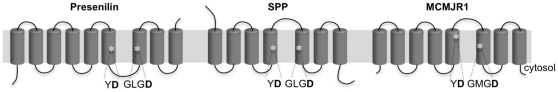
Topologies of presenilin, SPP and MCMJR1.A schematic of the predicted topologies of presenilin [10], SPP [20] and MCMJR1. Cylinders across the lipid bilayer (a continuous slab) depict the predicted TMD regions. Stars mark the positions of the catalytic aspartic acid residues.